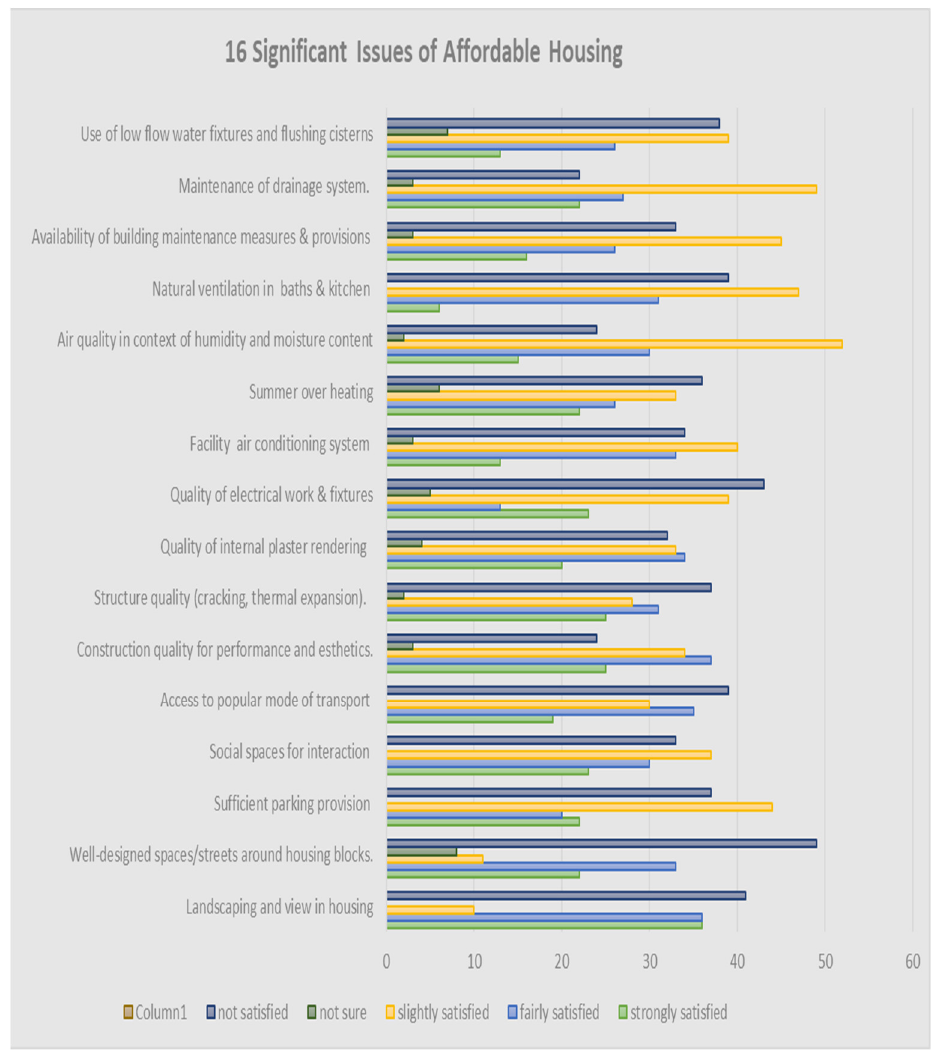
Figure 5. Significant affordable housing issues.